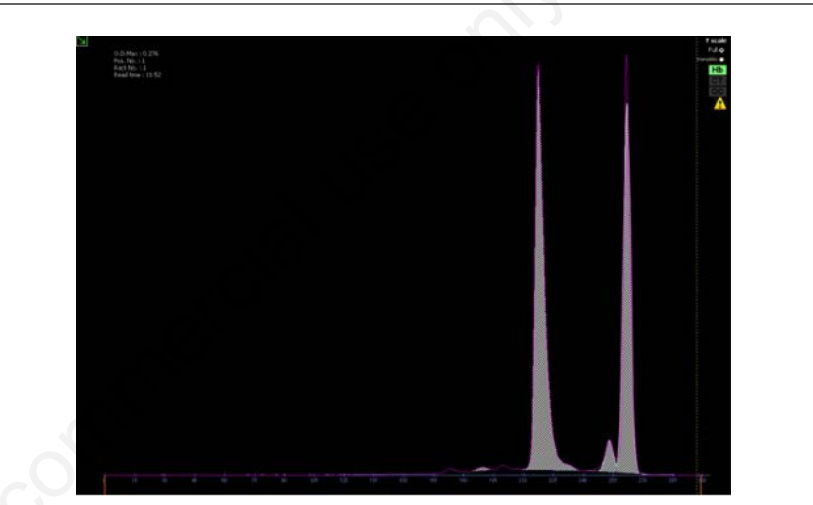
Figure 1. This the microscopic view of peripheral smear. Target cells seen. No sickle RBC identified.